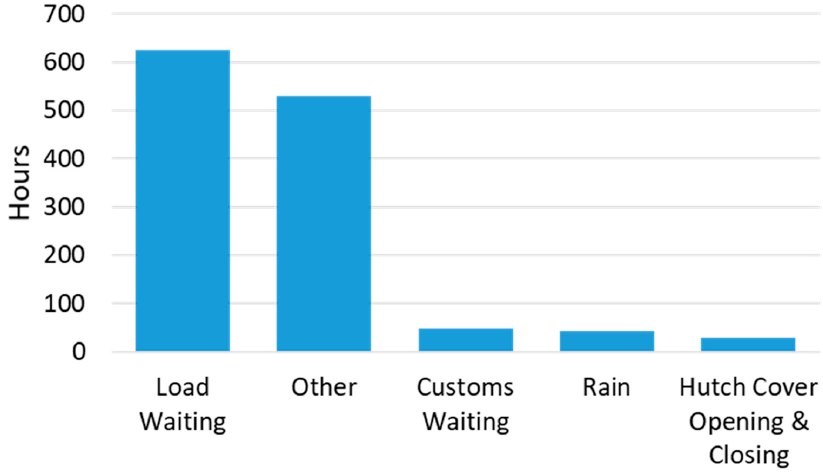
Figure 3. Waiting time and delays (average of years 2011–2021).